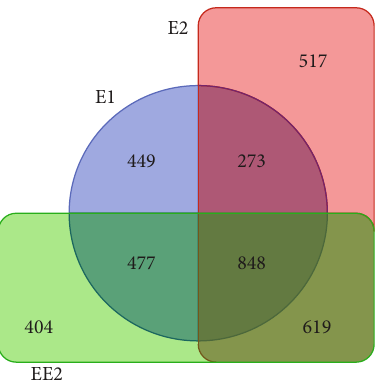
Figure 3: Venn diagram of di ff erentially expressed genes in di ff erent estrogen treatment groups.